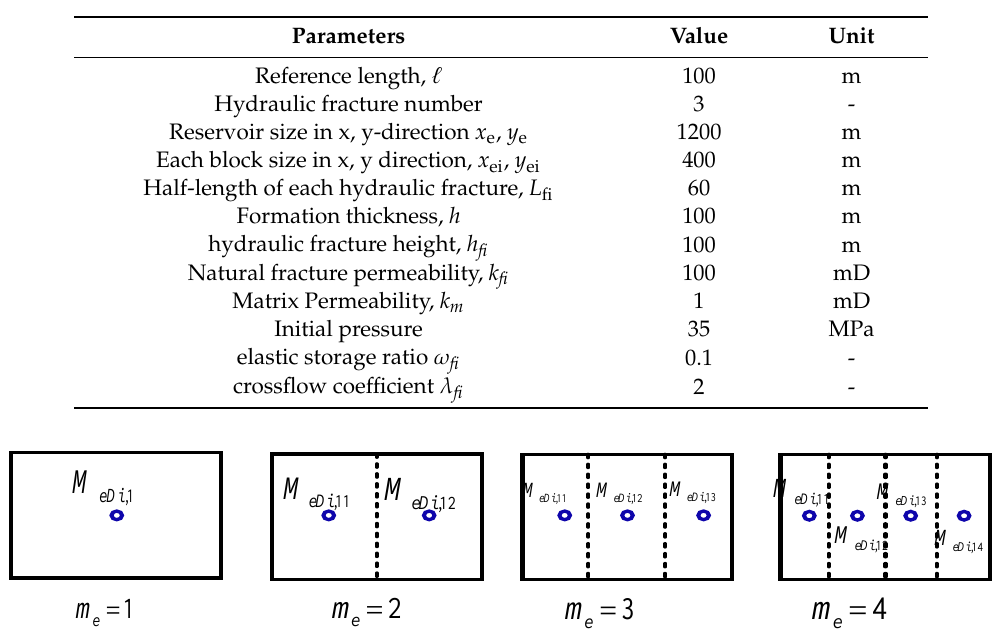
Table 1. Values of well and reservoir parameters.